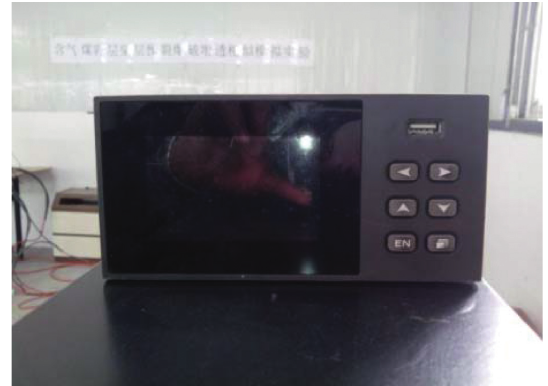
Figure 4: Automatic acquisition instrument for water pressure